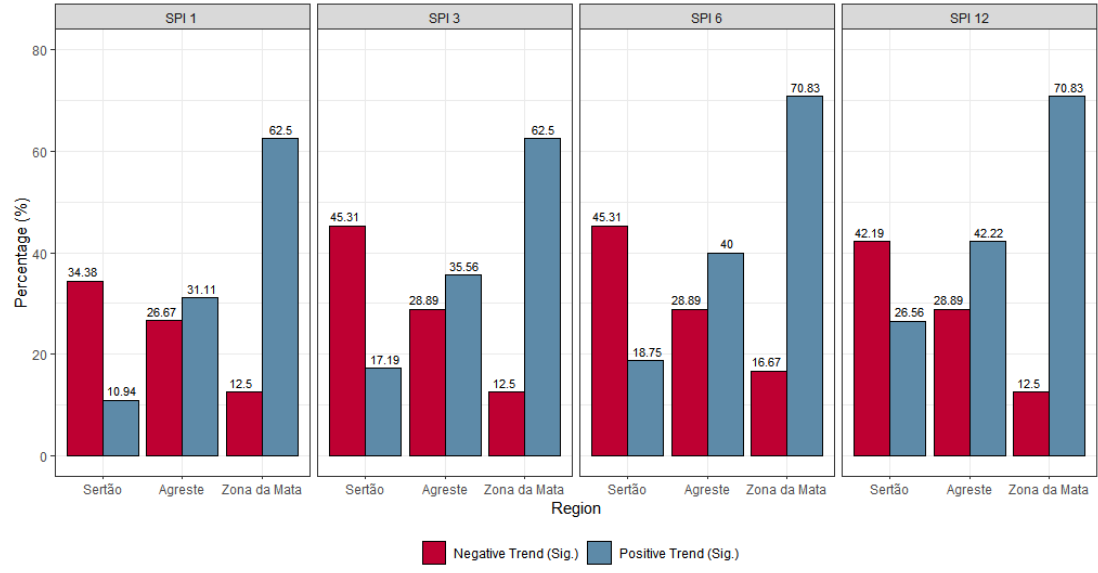
Figure 4. Results of the trend analysis for SPI at different time scales (SPI-1, SPI-3, SPI-6 and SP-12). For all time scales, percentage of non-significant trends ( 𝑝𝑣 ≥ 0.05 ) is lower than the percentage of significant trends. These percentages are 45% (26% Sertão, 14% Agreste, 5% Zona da Mata), 35% (18% Sertão, 12% Agreste, 5% Zona da Mata), 30% (17% Sertão, 11% Agreste, 2% Zona da Mata) and 28% (15% Sertão, 10% Agreste, 3% Zona da Mata) for time scales 1, 3, 6 and 12, respectively. Spatial distributions of trends (significant and non-significant) for the series of SPI values for time scales 1, 3, 6 and 12 months are shown in Figure 5. The downward oriented red triangles, and the upward blue triangles represent negative and positive trends, respectively, while filled triangles indicate significant trends. For all time scales, a general predominance of the negative tendencies (red triangles) can be seen in the Sertão region, indicating dominance of a drying tendency, while a predominance of positive trends (blue triangles) can be seen in Agreste and Zona da Mata, indicating the dominance of wetting tendency.